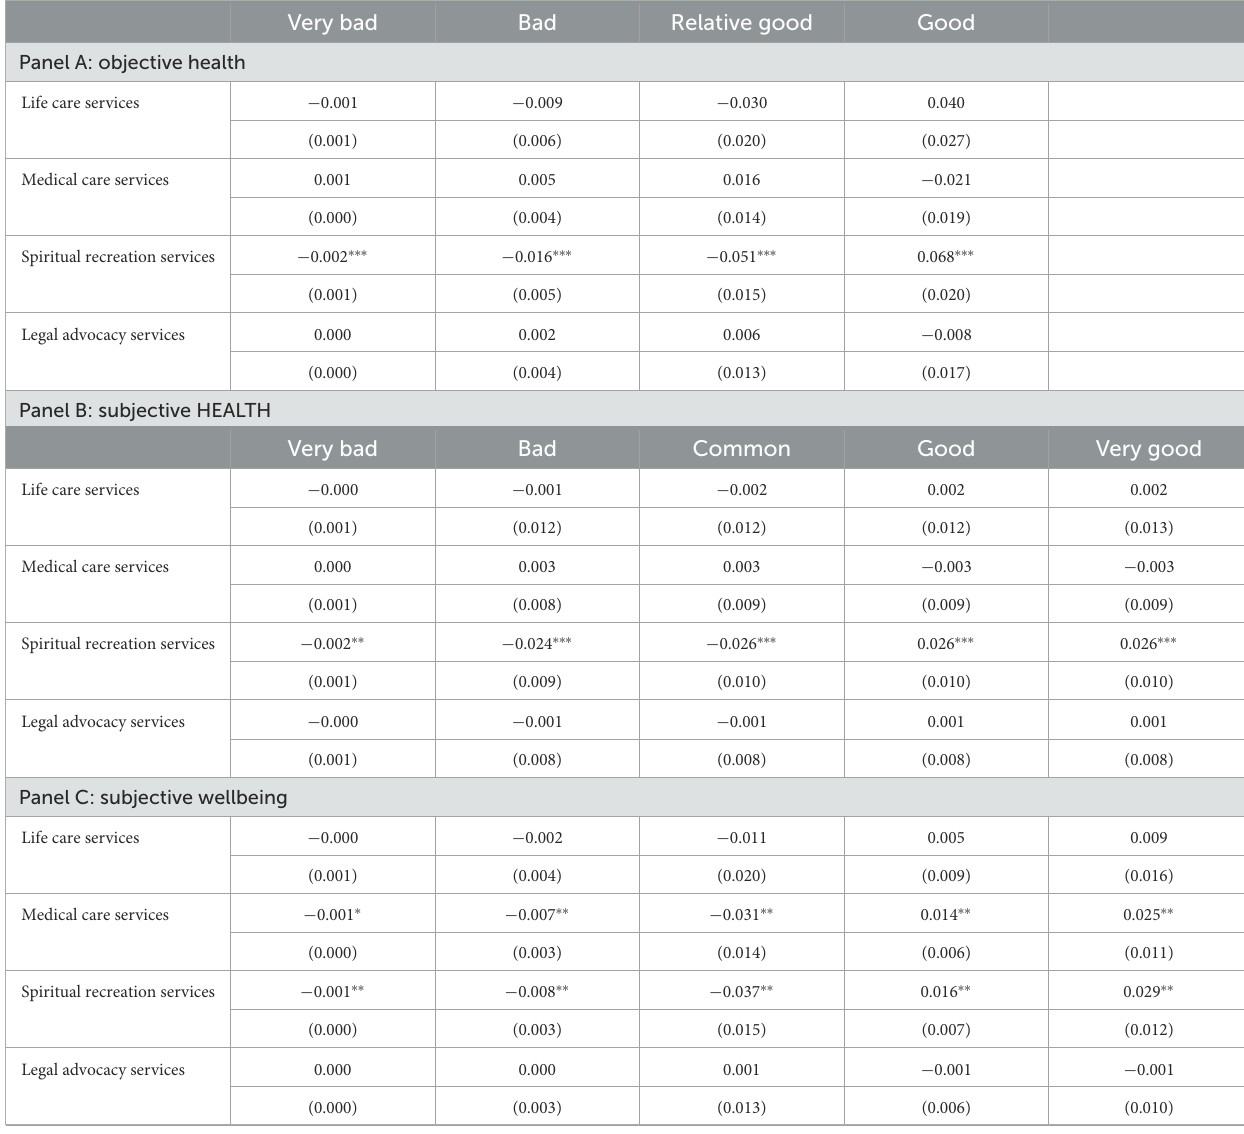
TABLE 5 Marginal effects of community care services on the health of older adults. Very bad Bad Relative good